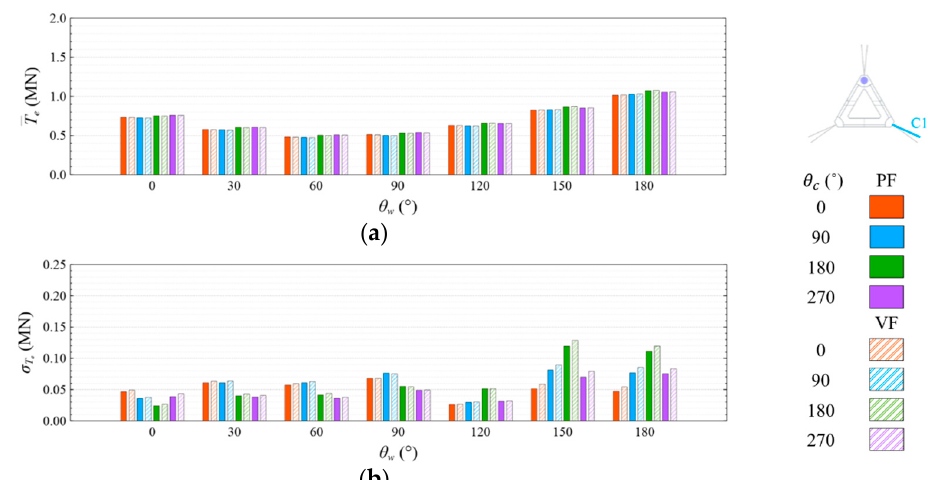
Figure 38. Comparison of ( a ) means and ( b ) standard deviations of mooring line tension of Line C1 under HW condition.